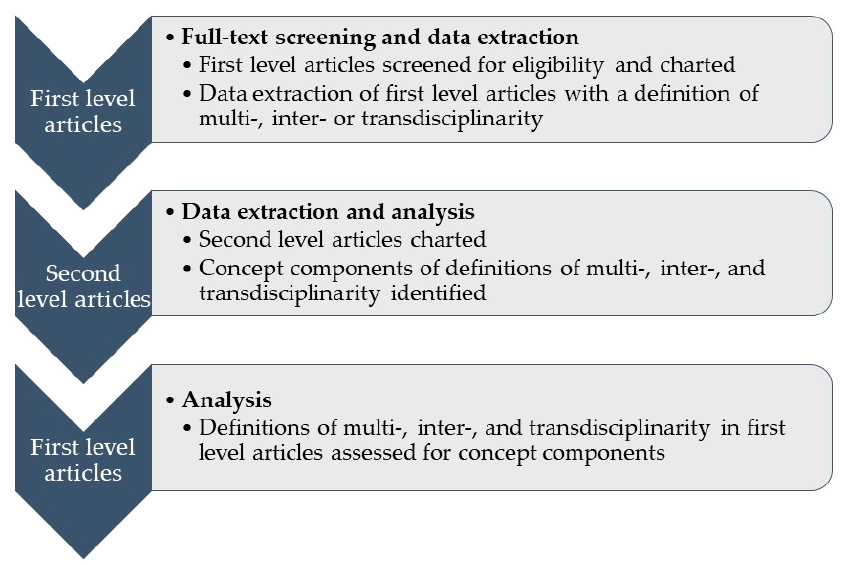
Figure 1. Overview of the data charting and analysis process.